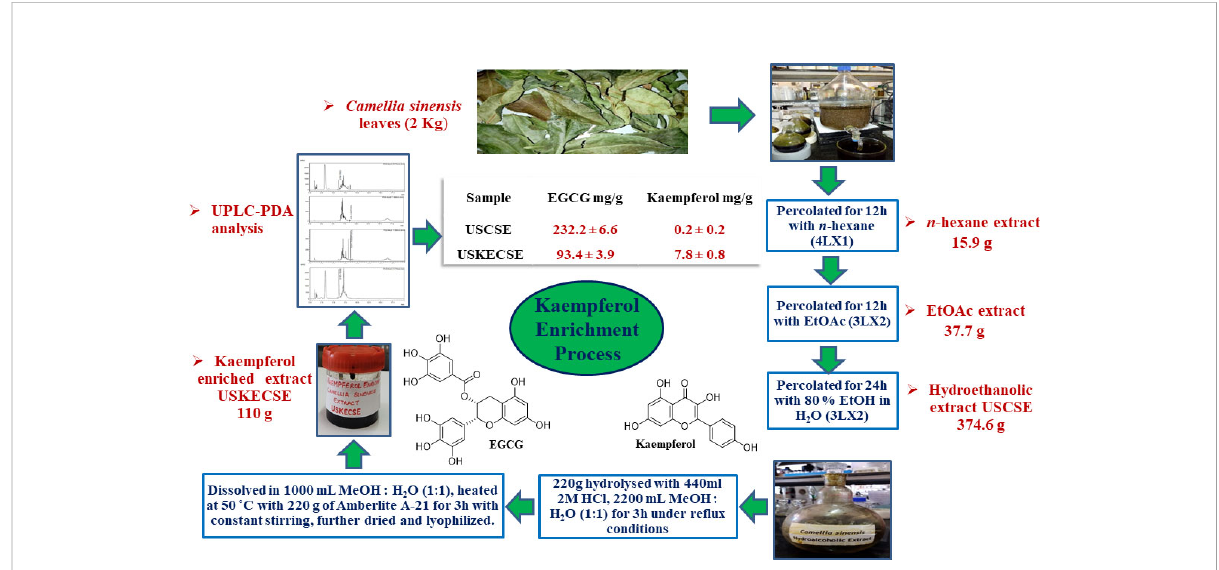
FIGURE 1 Schematic diagram showing the process of preparation of kaempferol-enriched extract (USKECSE) from C. sinensis